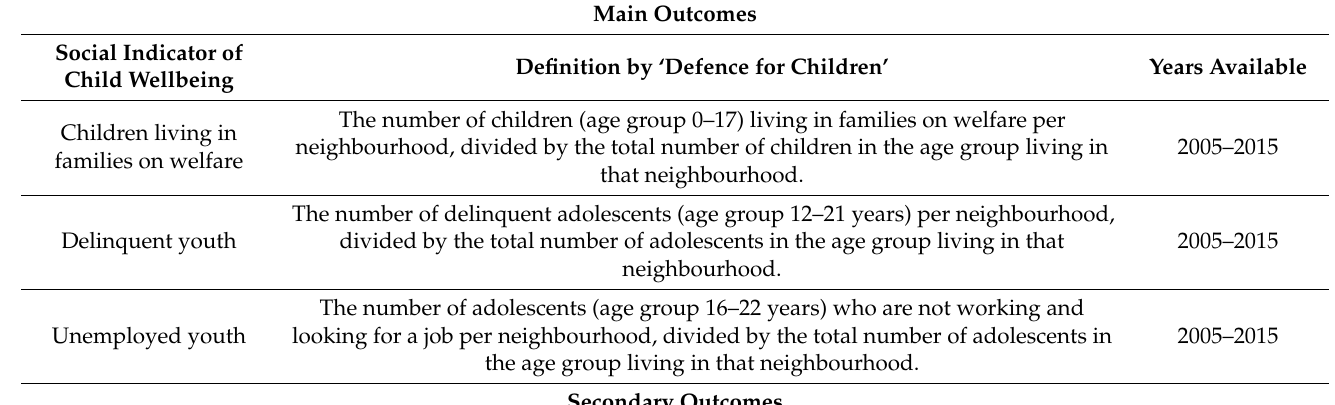
Table 1. Social indicators of child wellbeing by ‘Defence for